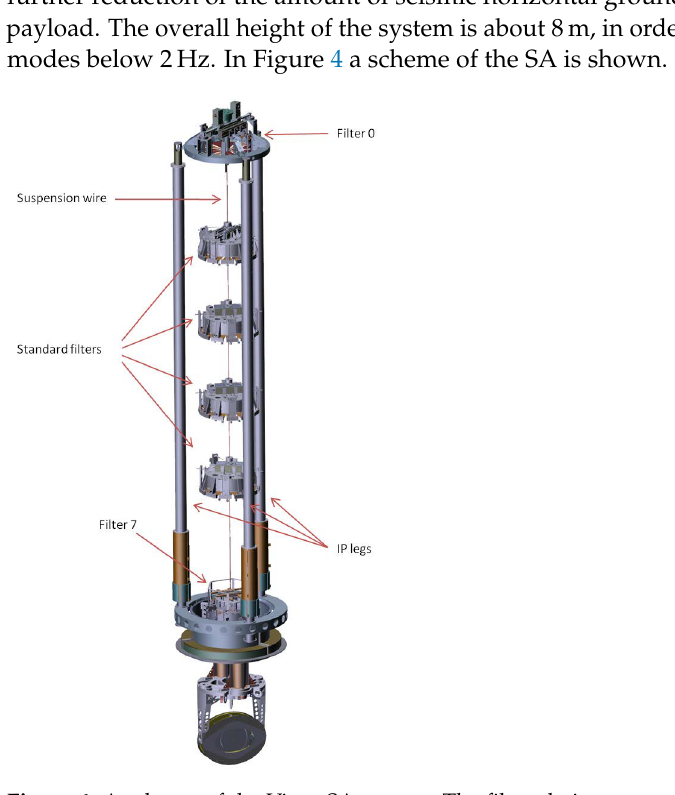
Figure 4. A scheme of the Virgo SA system. The filter chain starts with filter 0 at the top of the three legs of the inverted pendulum. Four standard intermediate filters and filter 7 complete the